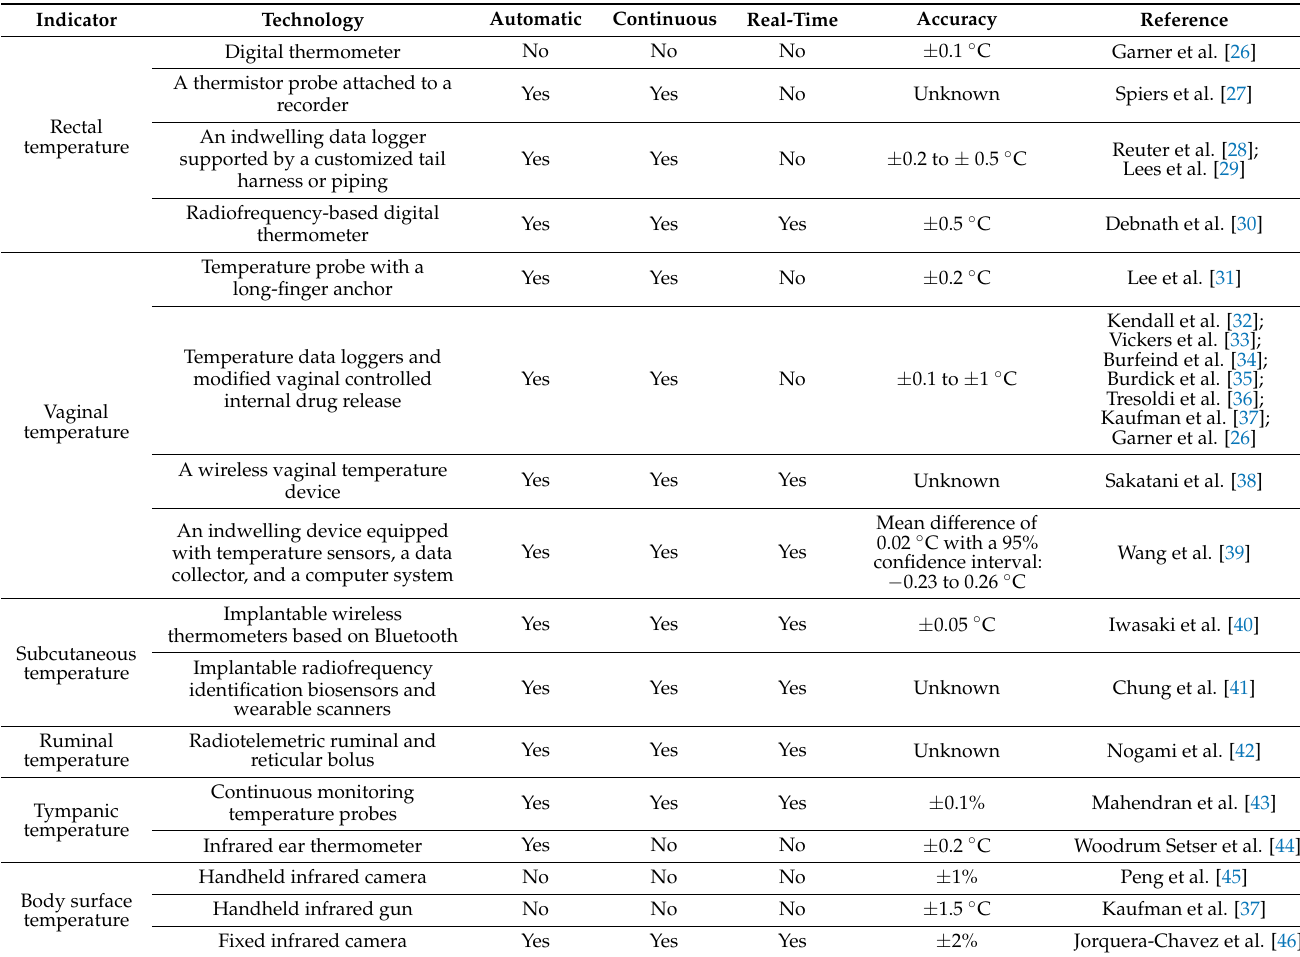
Table 1. Summary of the state-of-the-art measurement methods for body